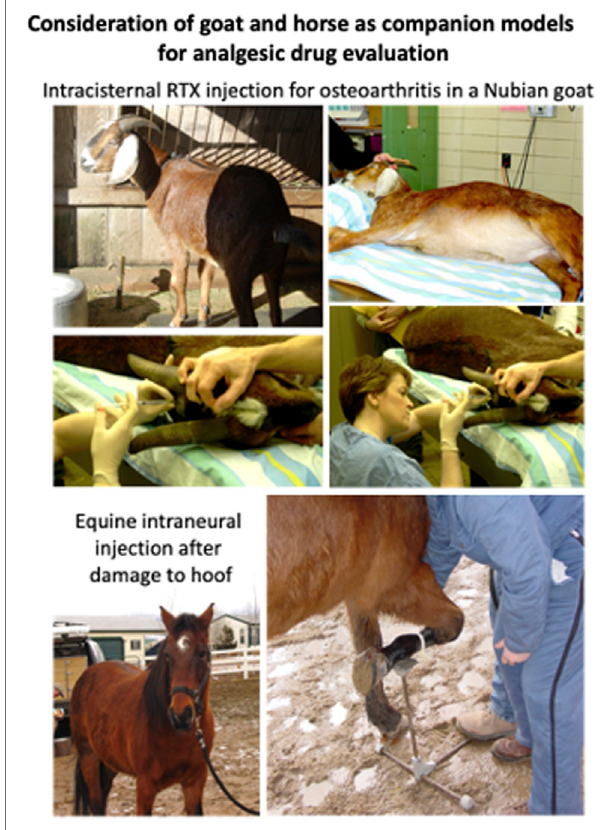
FIGURE 5 | Consideration of goat and horse as models for analgesic drugevaluation.Asdiscussedinthearticle,painfulconditionsinthehorseand goat represent other opportunities for animal analgesic assessment. The goats were treated intrathecally for painful osteoarthritis by RTX injection intothecisternamagnabyoneoftheauthors(DCB).Thisproducednoticeable improvements in activity. There were only two goats that had the arthritic problem, and this highlights the consideration of incidence and consistent access to a population with the appropriate disorder. The horse in the example was treated intraneurally with RTX and is shown just prior to surgical exposure of the nerve. This injection also produced a long duration analgesia ( ∼ 3 months) but it was not permanent (as expected with a distal peripheral injection). Compared to the goat, many more horses are candidates for such treatment, for example, laminitis is estimated at 10% of the equine population (Pollard et al., 2019). Other species have also been discussed in the literature (12, 13) and present challenges unique to each